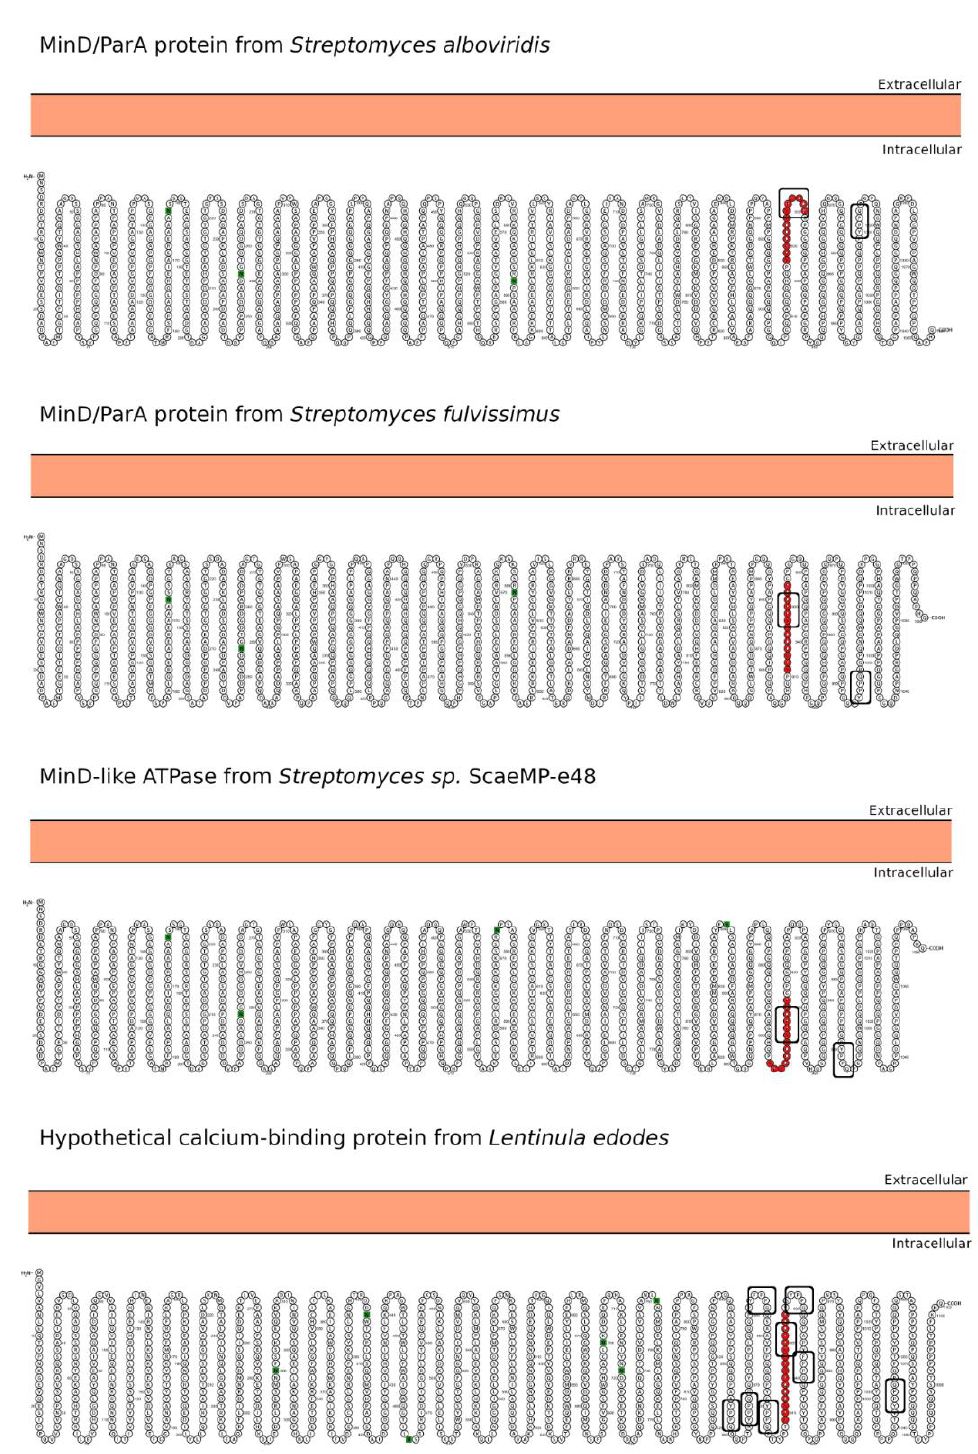
Figure 7. Predicted subcellular localization for the BLASTp hits proteins using the p31-43 sequence as a query. The localization of the high similarity sequence regions from the four best BLASTp hits is shown in red. The Y/FPPQ-binding motif recognized by the WW domain is highlighted with a rectangle. The analysis was performed using the Protter server [82]. The N-glycosylation motifs are marked as green squares.